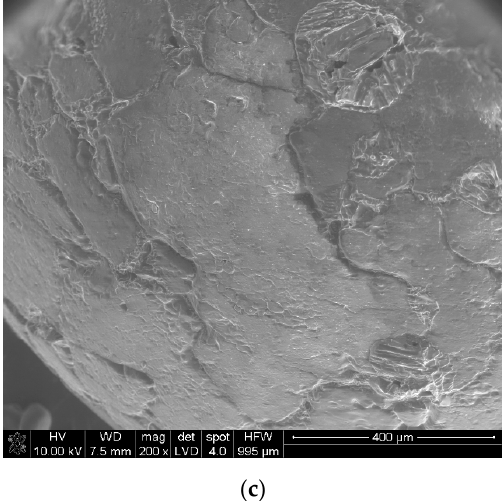
Figure 1. Scanning electron microscopy (SEM) images of prill at a magnification of 200x: ( a ) AN-PP8; ( b ) AN-PP7; ( c ) AN-F.